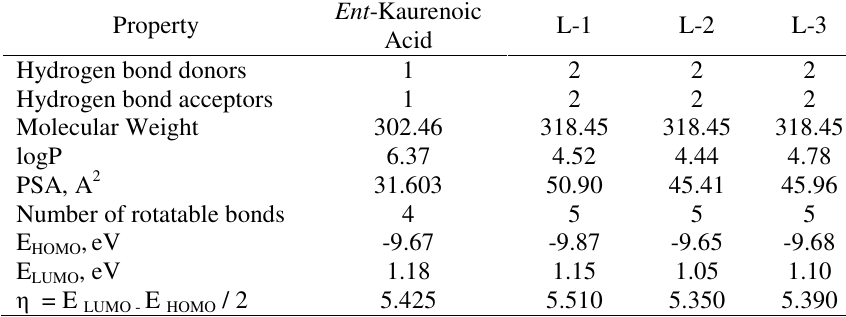
Figure 7. Proposed hydroxylation method and the corresponding products Table 4. Comparison of properties among ent -kaurenoic acid and its hydroxylated